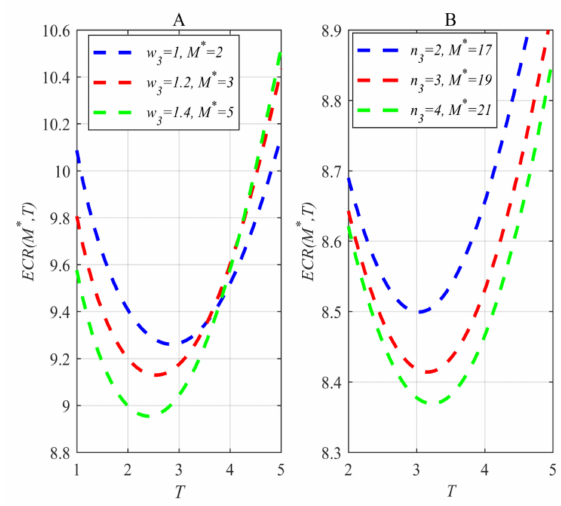
Figure 7. The effect of n 3 and w 3 on the optimal